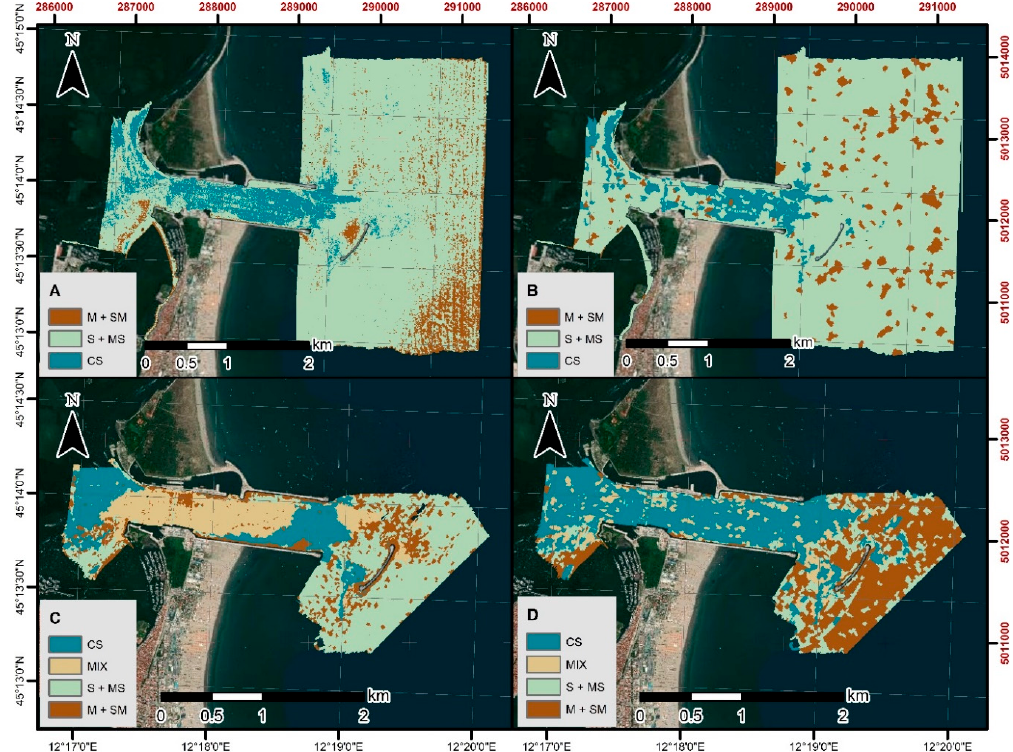
Figure 5. Classification results of four sediment composition models: ( A ) Chioggia 2013 dataset, Boruta feature selection, RF classifier, scale 4 of multiresolution segmentation; ( B ) Chioggia 2013 dataset, CART feature selection, Bayes classifier, scale 50 of multiresolution segmentation; ( C ) Chioggia 2016 dataset, CART feature selection, CART classifier, scale 23 of multiresolution segmentation; and ( D ) Chioggia 2016 dataset, Boruta feature selection, RF classifier, scale 32 of multiresolution segmentation. Table 3. Error matrices with accuracy assessment for all Chioggia datasets: ( A ) Chioggia 2013 dataset, Boruta feature selection, RF classifier, scale 4 of multiresolution segmentation; ( B ) Chioggia 2013 dataset, CART feature selection, Bayes classifier, scale 50 of multiresolution segmentation; ( C ) Chioggia 2016 dataset, CART feature selection, CART classifier, scale 23 of multiresolution segmentation; and ( D ) Chioggia 2016 dataset, Boruta feature selection, RF classifier, scale 32 of multiresolution segmentation.